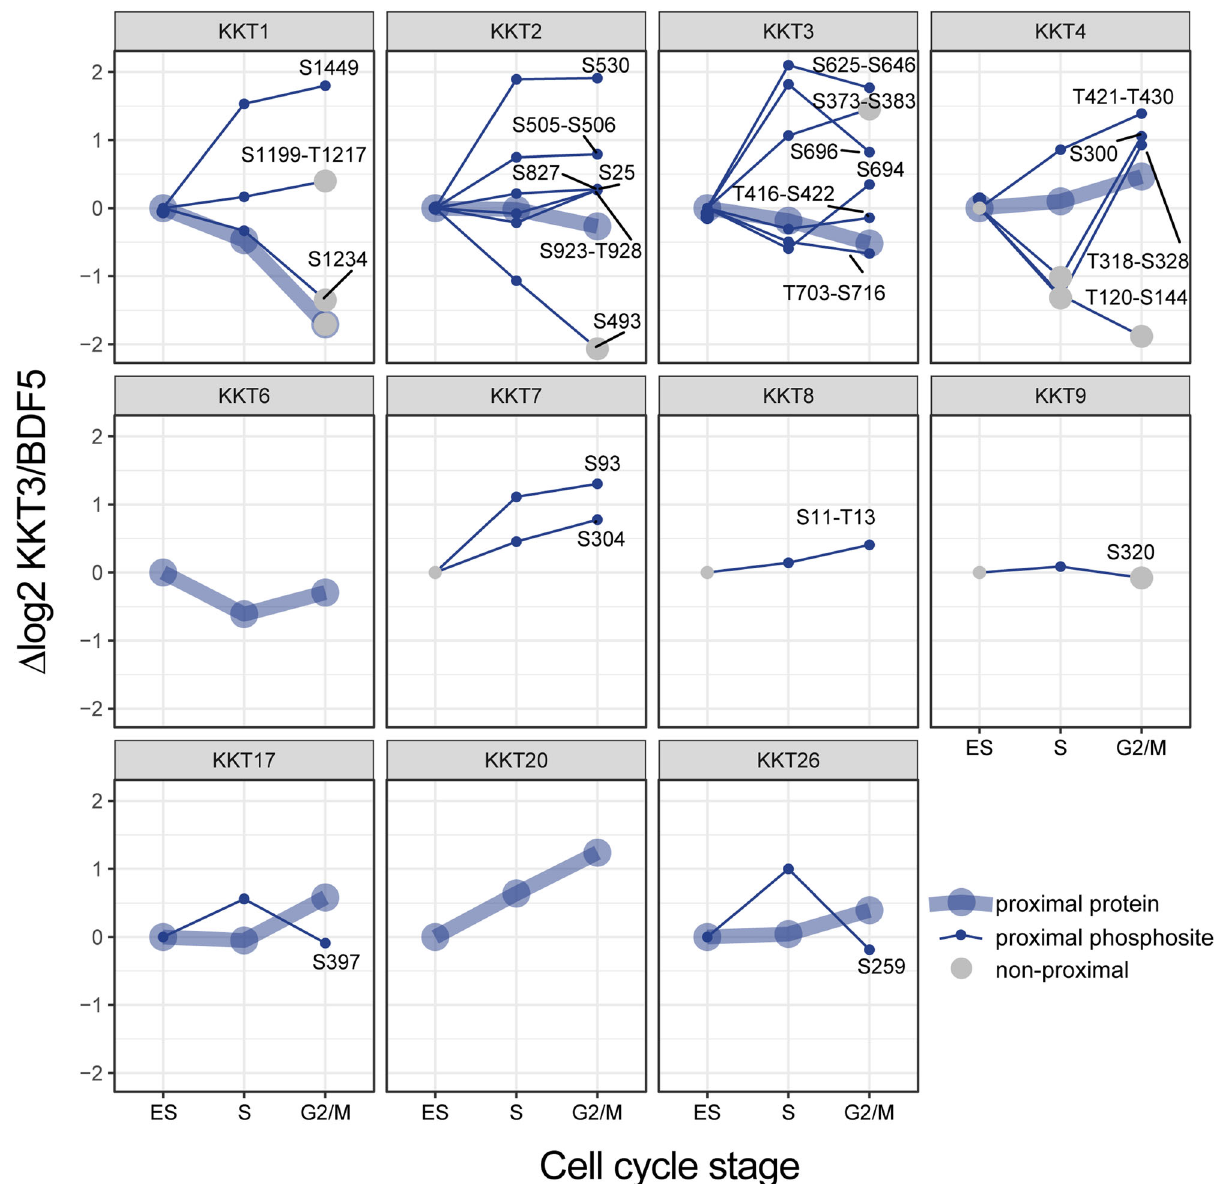
Fig. 3 Proximal pro fi le plots of kinetochore proteins and phosphosites during the cell cycle. Kinetochore proteins and phosphosites proximal in at least one of the timepoints are shown. At each timepoint, mean log2 fold enrichments against BDF5::mT spatial reference are normalised to the log2 fold enrichment at time 0, n = 5. Where a phosphosite could not be con fi dently localised, the possible phosphorylated region is